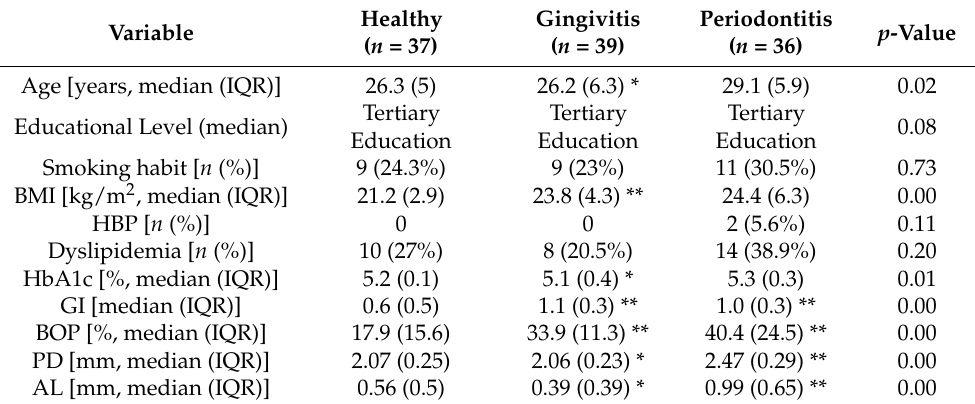
Table 1. Demographic, clinical, and hematological parameters of study